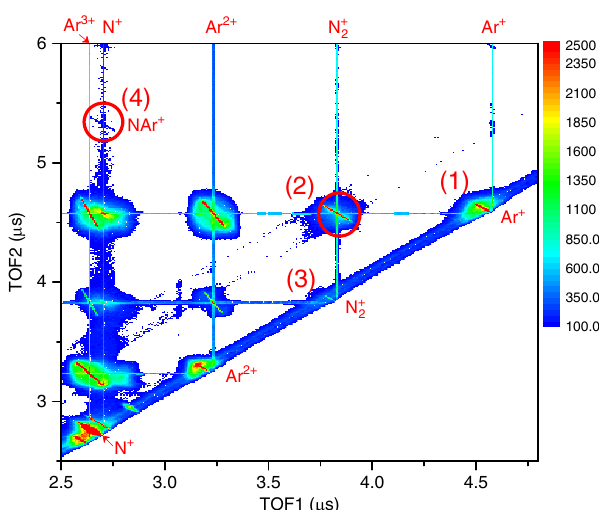
Fig. 1 Two-dimensional TOF correlation map. The coincidence map shows the time-of- fl ights between the fi rst and the second fragment ions arriving at the detector. The product ion species are labeled in the plot for horizontal and vertical axes according to their TOFs, respectively. The corresponding reactions labeled with a number are explained in the